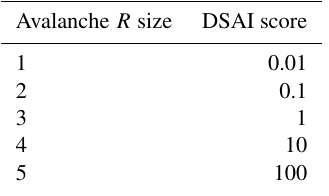
Table 2. DSAI score for each R -size designation. Avalanche R